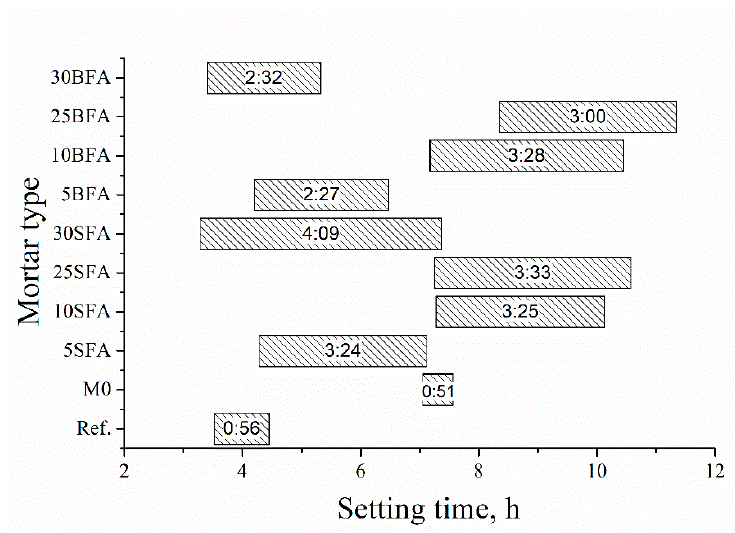
Figure 2. Setting time of tested mortars.